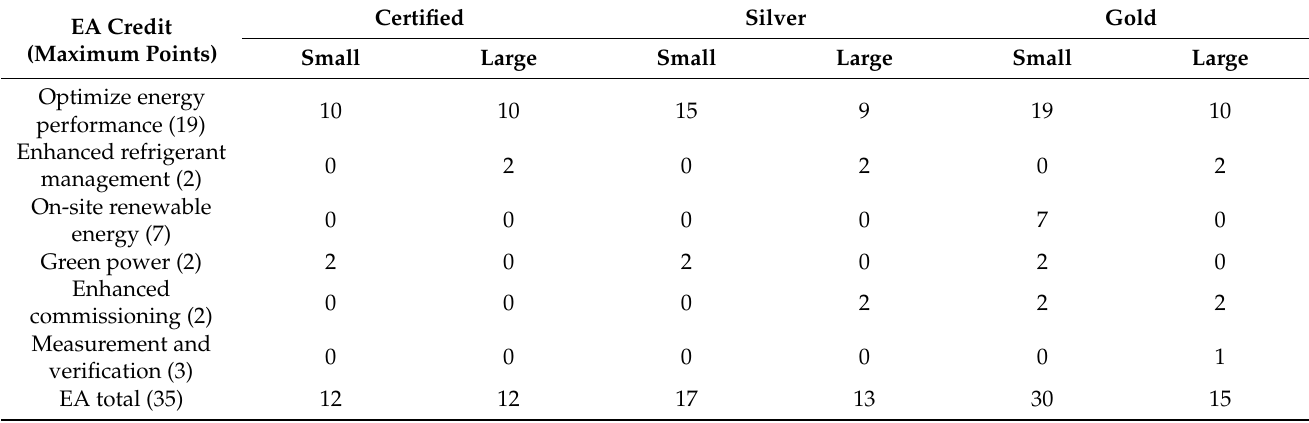
Table 6. The Energy and Atmosphere (EA) credits in three small and three large project sizes in LEED-NC v3 projects.